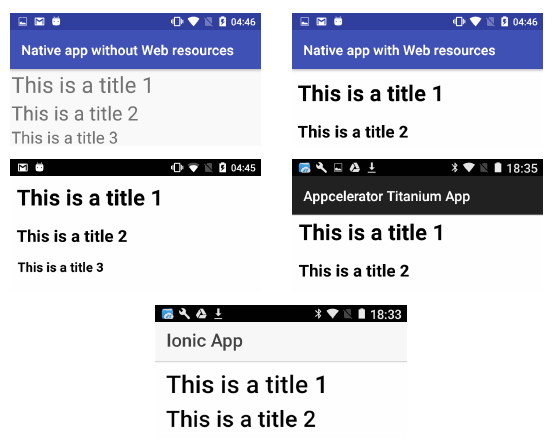
Fig. 5. Component ”title of the sections” implemented in the native ap- plication (without Web resources), native application (with Web resources), Cordova application, Appcelerator application and Ionic application, respec-